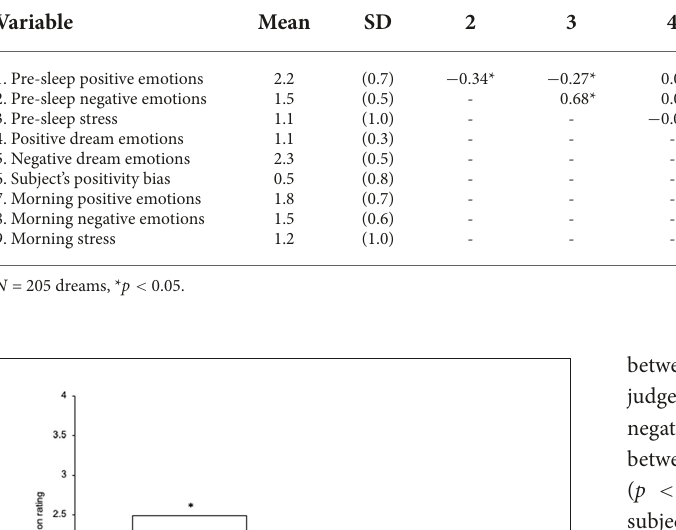
N = 117 dreams, * p < 0.05.